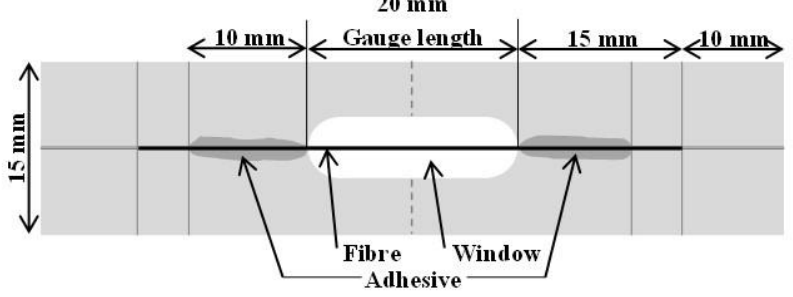
Figure 3. Schematic diagram of mounting tab for single fibre testing.